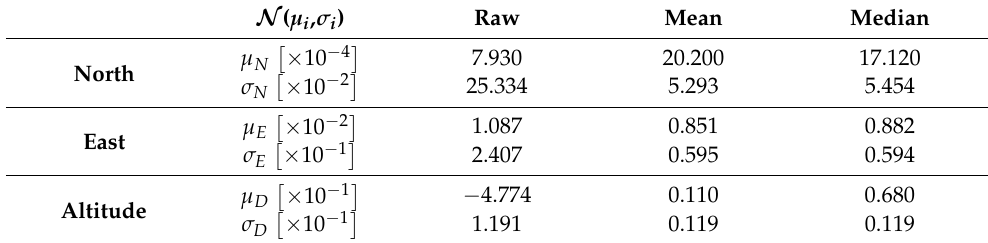
Table 4. Gaussian density distribution approximation.